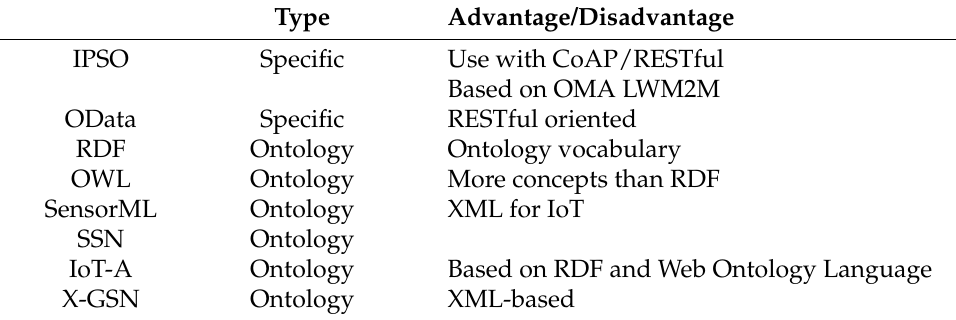
Table 8. Comparison of syntax and semantics